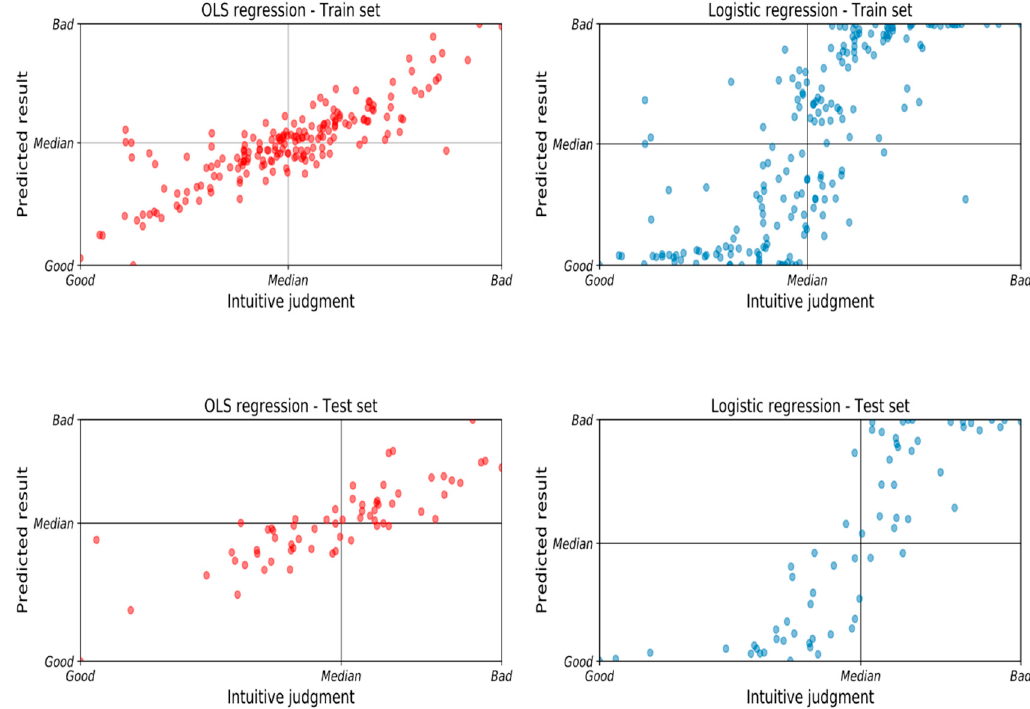
Figure 8. The predicted results were compared with a training (75% in the upper plots) and a test (25% in the lower plots) sample. The horizontal axis presents the original acceleration average level and the vertical axis presents the predicted results in OLS regression ( left ) and logistic regression ( right ). Table 6. Classification results of training and test data.